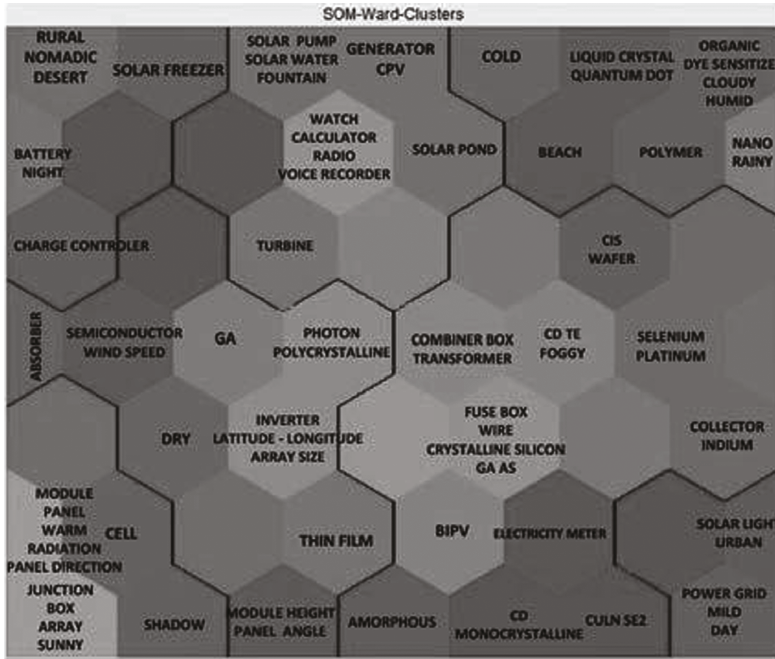
Figure 5: Clusters of keywords using the SOM